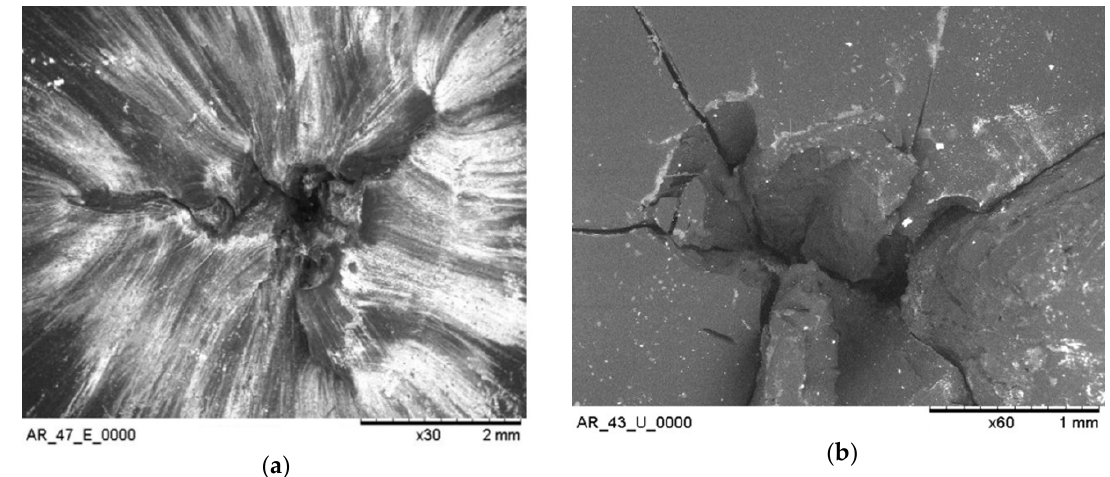
Figure 9. SEM images projectile entrance side ( a ) exit side ( b ) after two shots in the same location.